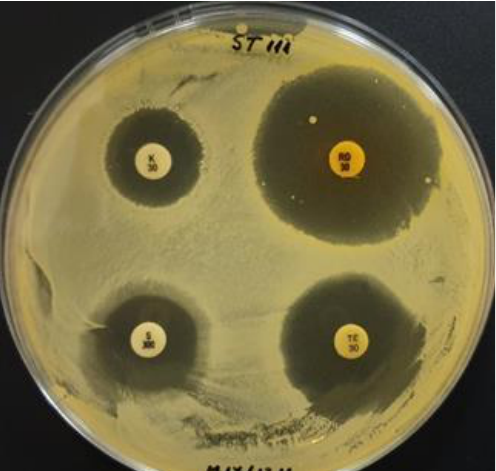
Figure 2. Susceptibility of ST111 strain to four antibiotics: kanamycin (K30) (left-up), rifampicin (RD30) (right-up), streptomycin (S300) (left-down), and tetracycline (TE30) (right-down).